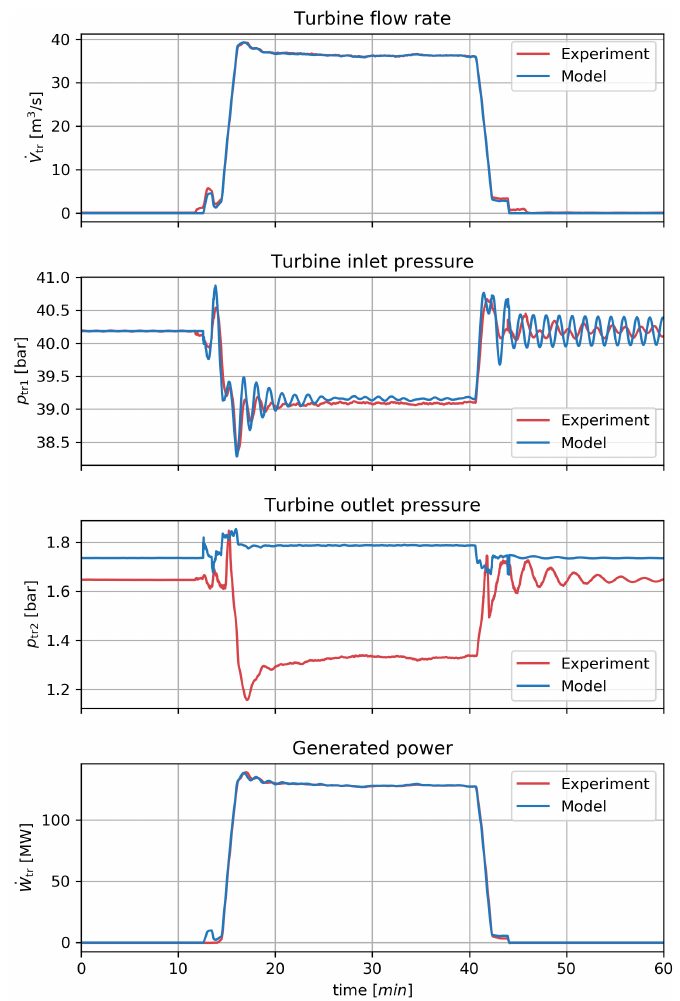
Figure 6. Comparison of the simple hydropower model simulation results and the experimental